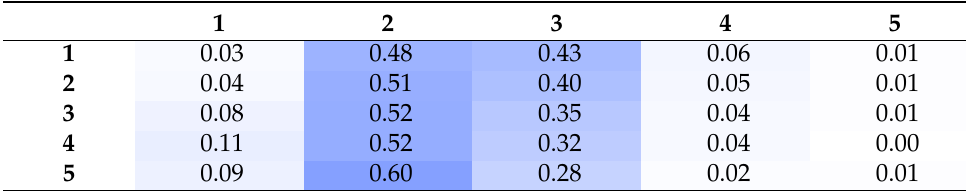
Table 10. Transition probability matrix: speed to